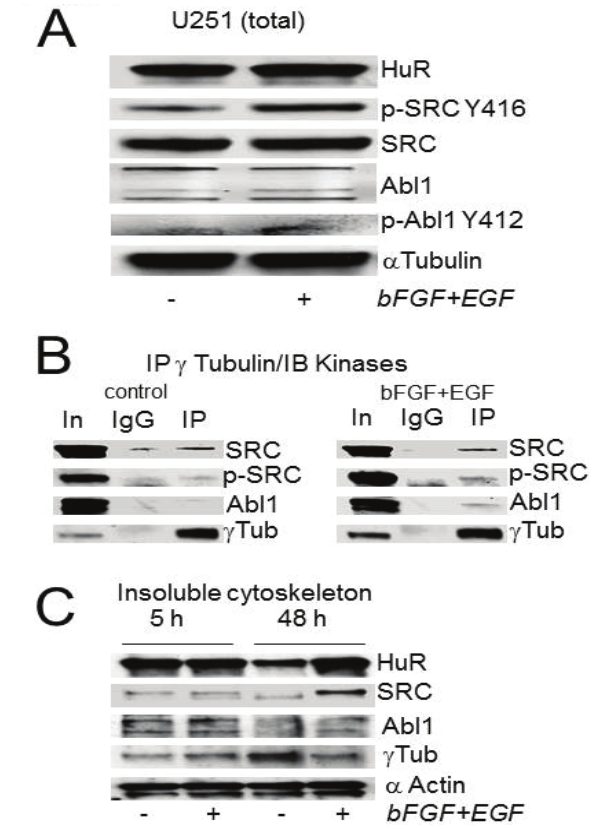
Figure 4. The association of Abl-1 and SRC kinases with the PCM and cytoskeleton is growth factor dependent. ( A ) Example of Western blot demonstrating the alteration of pY status in the catalytic domains of SRC and Abl-1 kinases induced by growth factor stimulation. ( B ) Co-immunoprecipitation of SRC and Abl-1 kinases with (cid:2)-tubulin in control and growth factor stimulated conditions. Note that the Abl-1 kinase exhibits significant enhance in co-immunoprecipitation with (cid:2)-tubulin following growth factor stimulation. ( C ) The contents of non-soluble cytoskeleton fractions obtained from control and growth factor stimulated (for 5 h and 48 h) conditions. There is a significant enhancement of HuR and SRC